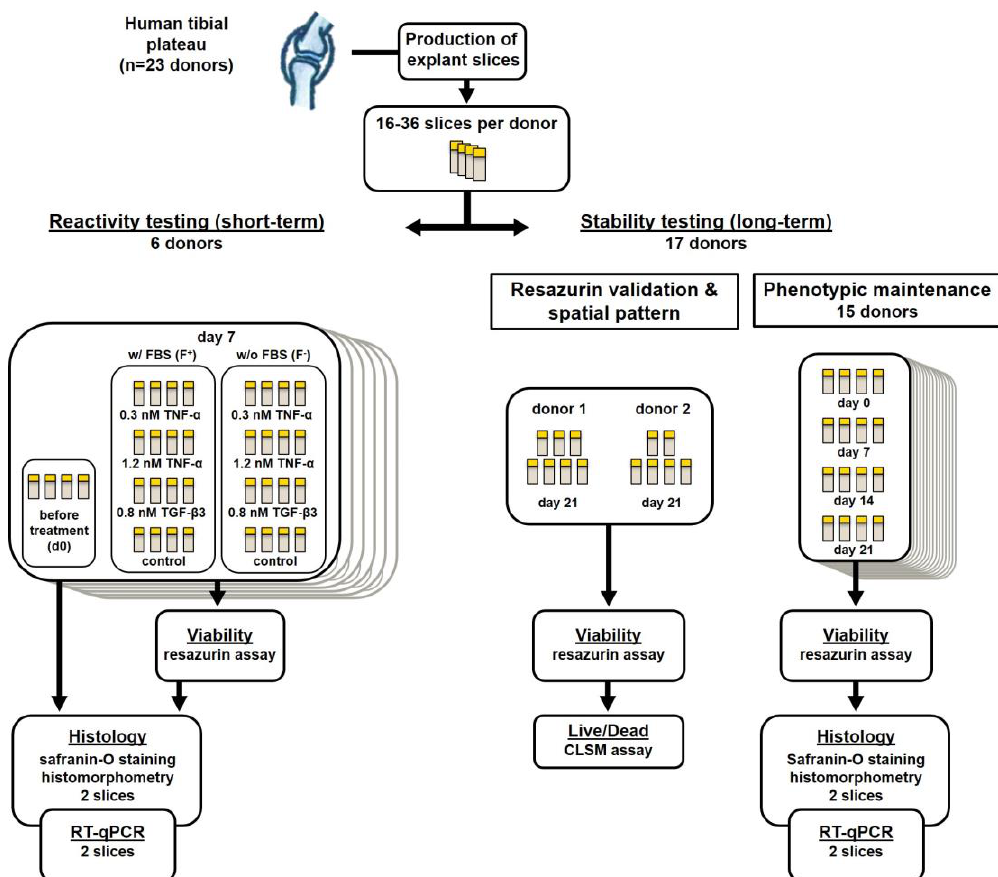
Figure 5. Flowchart depicting donor sample acquisition and distribution. Samples were obtained and then distributed for use in short-term (7 days, donors 1–6) stimulation experiments or long-term (21 days, donors 7–23) viability and gene expression experiments.